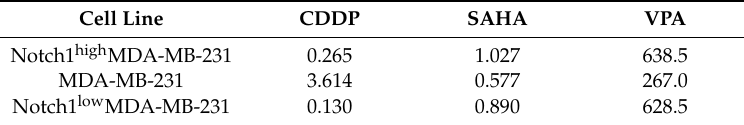
Table 1. IC 50 values ( µ g / mL) for CDDP and HDIs (SAHA and VPA) in transfected and native [28] MDA-MB-231 breast cancer cells.